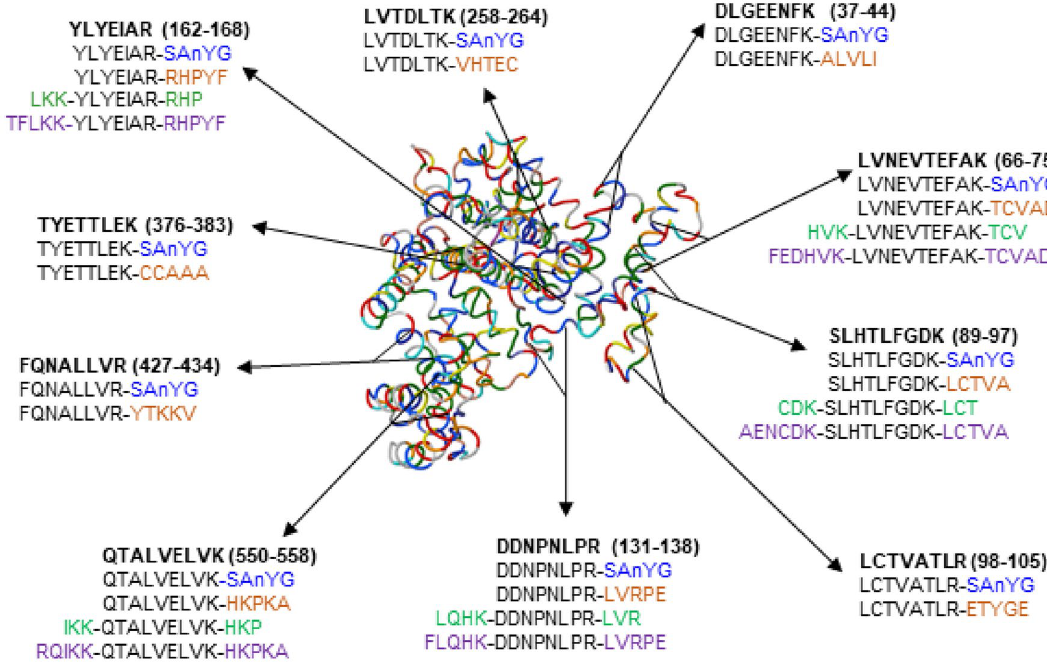
Figure 1. Signature proteotypic peptides are marked in bold, a peptide position in the HSA protein sequence in brackets. Compared types of SIL-Ex peptides are shown in different colors: SIL-TCT (blue), SIL-ExC5 (orange), SIL-ExC3N3 (green), SIL-ExC5N5 (purple). SIL-ExC5, SIL-ExC3N3, and SIL-ExC5N5 denote signature peptides extended with the natural sequence of amino acids corresponding to the target protein sequence. SIL- TCT represent signature peptides extended with a tetrapeptide (SAnYG, nY = nitrotyrosine)